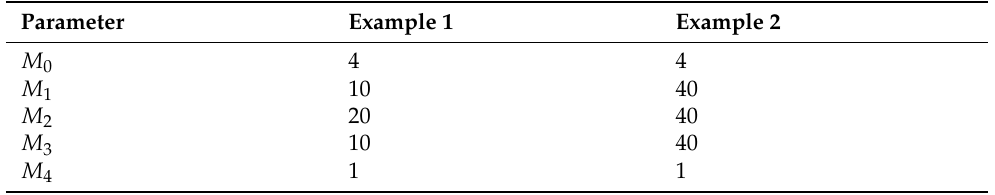
Table 3. Selection of the HNN structure in different examples.